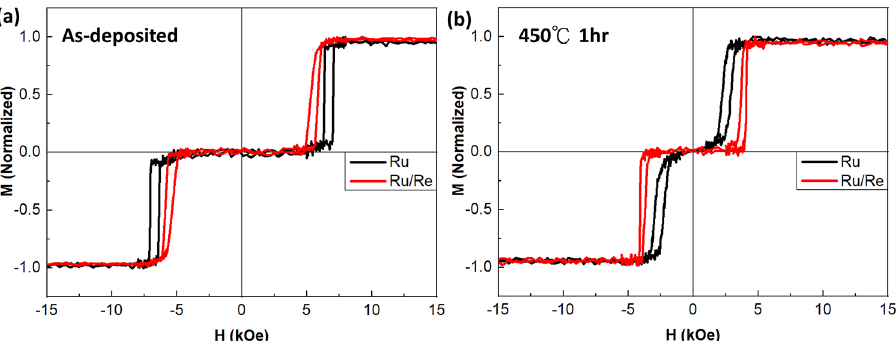
Figure 2. M-H loops of [Co/Pt] n based SAFs. Black curve is for the sample with a single Ru spacer of 0.79 nm and red one is for the sample with a composite spacer of Ru 0.61 nm/Re 0.18 nm. ( a ) As-deposited state ( b ) After 450 °C 1 h